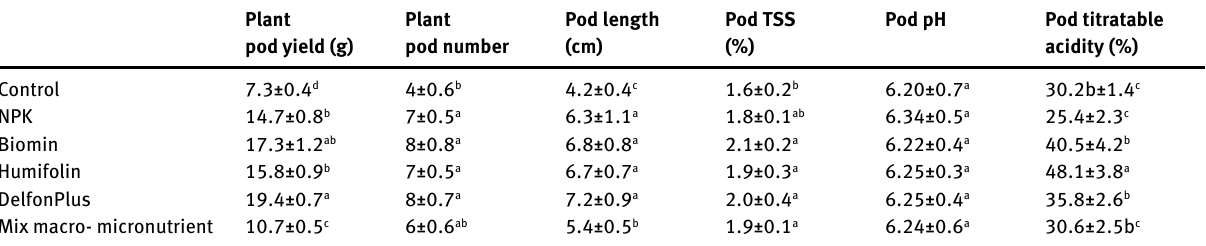
Table 4: Mean values (± SD) of yield and pod quality of green bean plants treated with foliar applications of different organic chelates, a mix of nutrients and soil applied NPK under greenhouse conditions. In each column means with at least one common letter are not significantly different